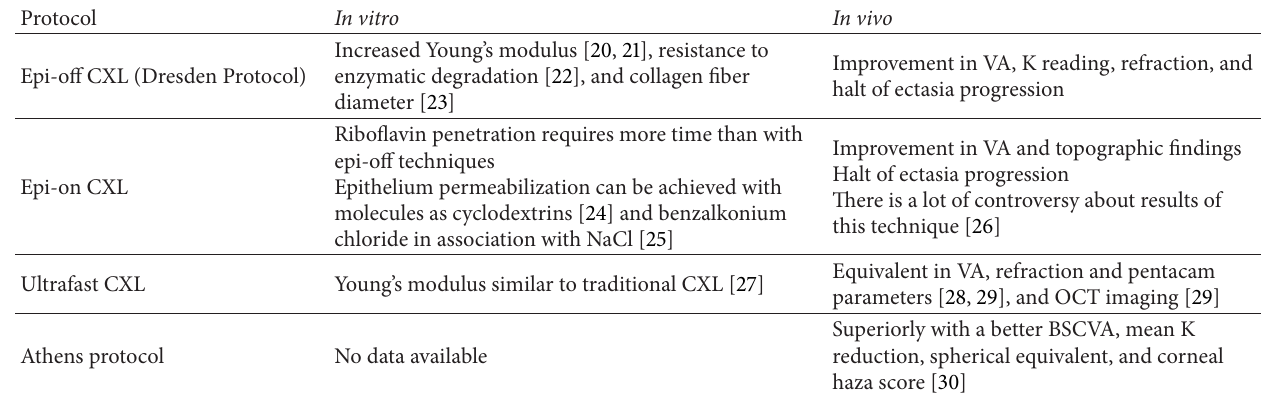
Table 1: In vitro and in vivo evidences of corneal cross-linking